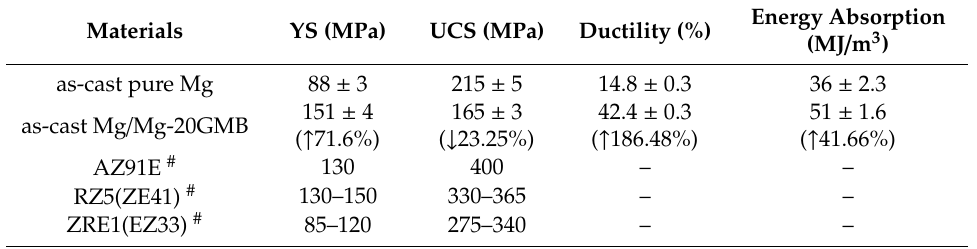
Figure 7. ( a ) Compression stress–strain graphs, and fracture appearance of ( b ) as-cast pure Mg, and ( c ) as-cast Mg / Mg-20GMB hybrid composite. Table 4. Compression properties of as-cast pure Mg and Mg / Mg-20GMB hybrid composite and other reported commercial Mg